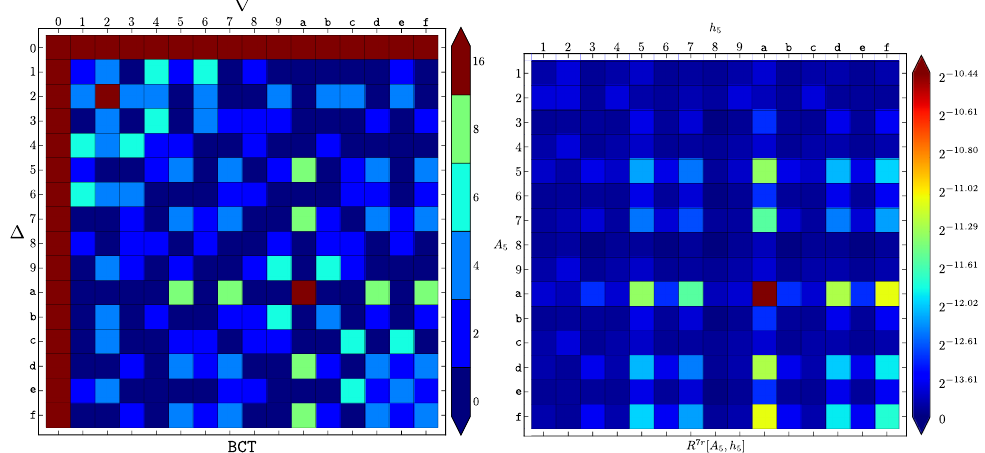
Figure 8: Visualization for the BCT of CRAFT ’s S-box (left) and the probability matrix R 7 r (right)